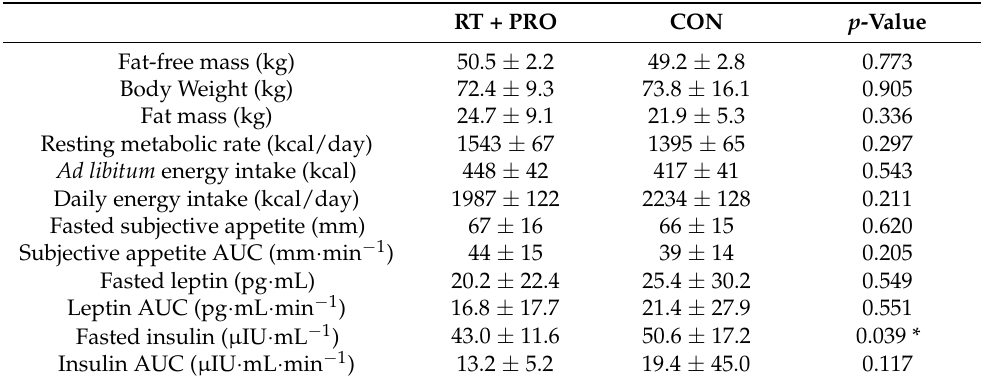
Table 2. Baseline characteristics of the resistance training and protein supplementation (RT + PRO) and control (CON). RT + PRO